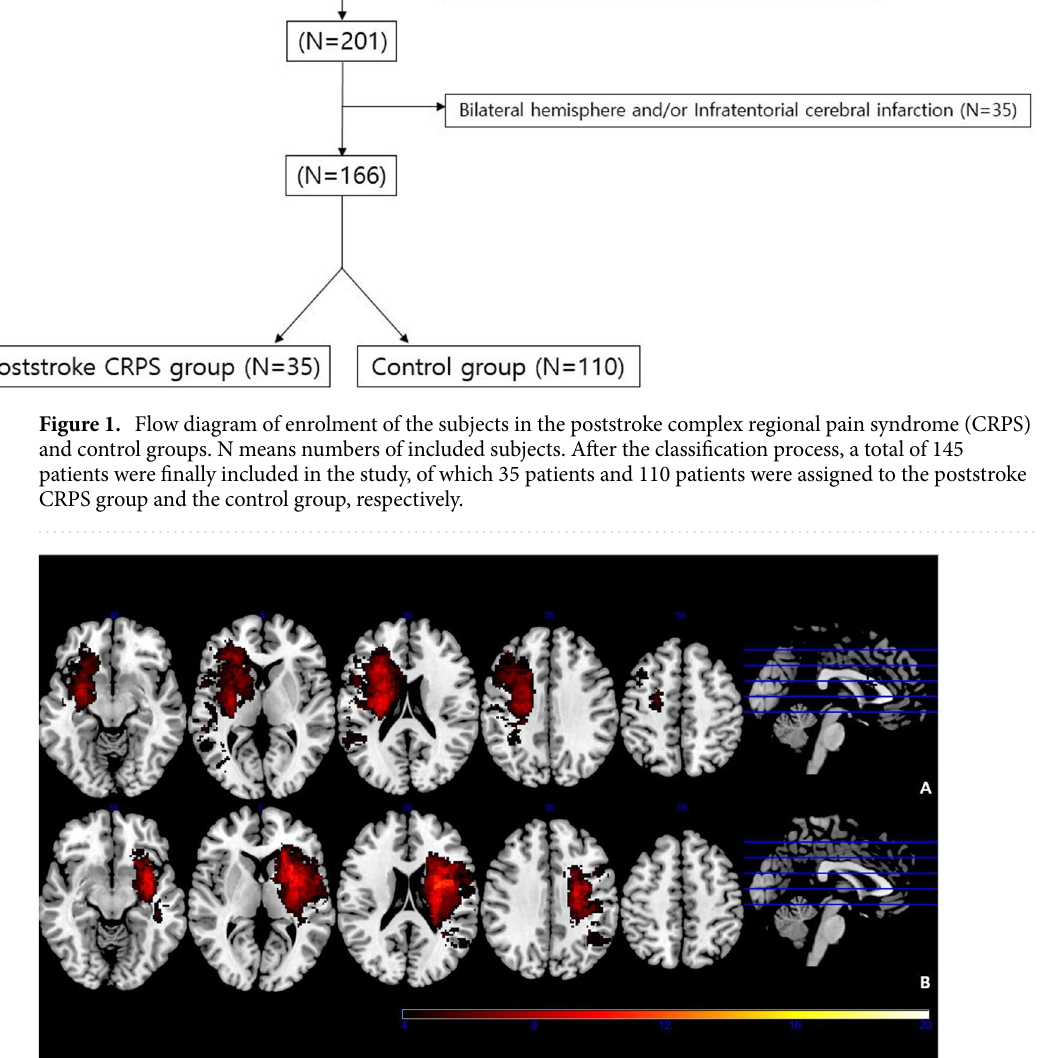
right and left hemispheres in the poststroke CRPS group (Fig. 2). After flipping, the lesions were drawn manu- ally on the patients’ FLAIR images. These images were co-registered with the patients’ own T1W images. They were then normalized to Montreal Neurologic Institute (MNI) space using T1W normalization parameters and Statistical Parametric Mapping (SPM) 12 software (Wellcome Department of Neuroscience, London, UK; http:// www. fil. ion. ucl. ac. uk/ spm/ softw are/ spm12/). After normalization, the voxel size was 2 × 2 × 2 mm 3 . Normalized lesions were subjected to statistical mapping analysis using VLSM algorithms implemented with the Statisti- cal Non-Parametric Mapping (SnPM) toolbox (https:// warwi ck. ac. uk/ fac/ sci/ stati stics/ staff/ acade mic- resea rch/ nicho ls/ softw are/ snpm). After considering clinical parameters (age and sex), VLSM analysis revealed clusters of voxels that were significantly and more frequently identified in the poststroke CRPS group than in the con- trol group. Statistical significance was determined by voxel-level permutation correction at p < 0.05 family-wise